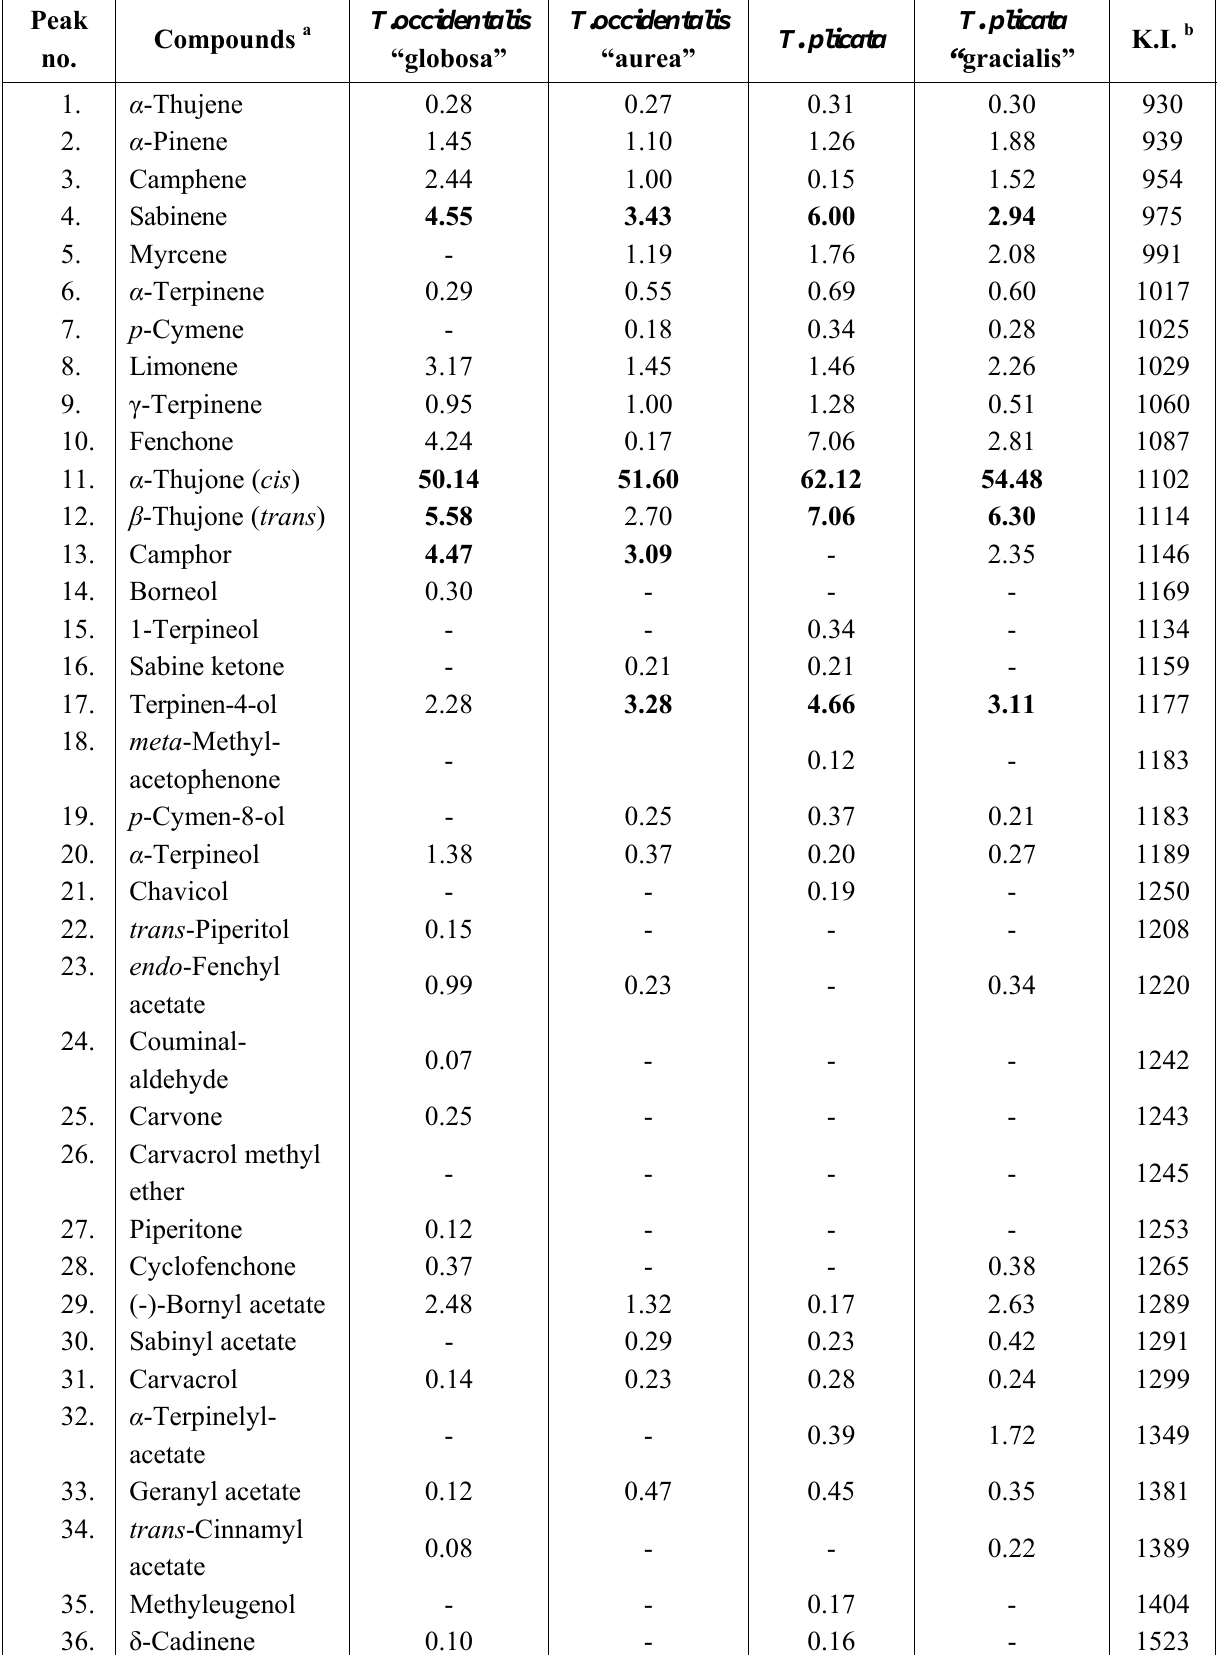
Table 1. Quantities (%) of components of the volatiles of four Thuja essential oils.